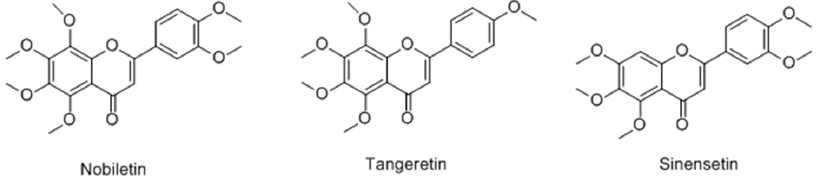
Figure 16. Structures of polymethoxylated flavones .